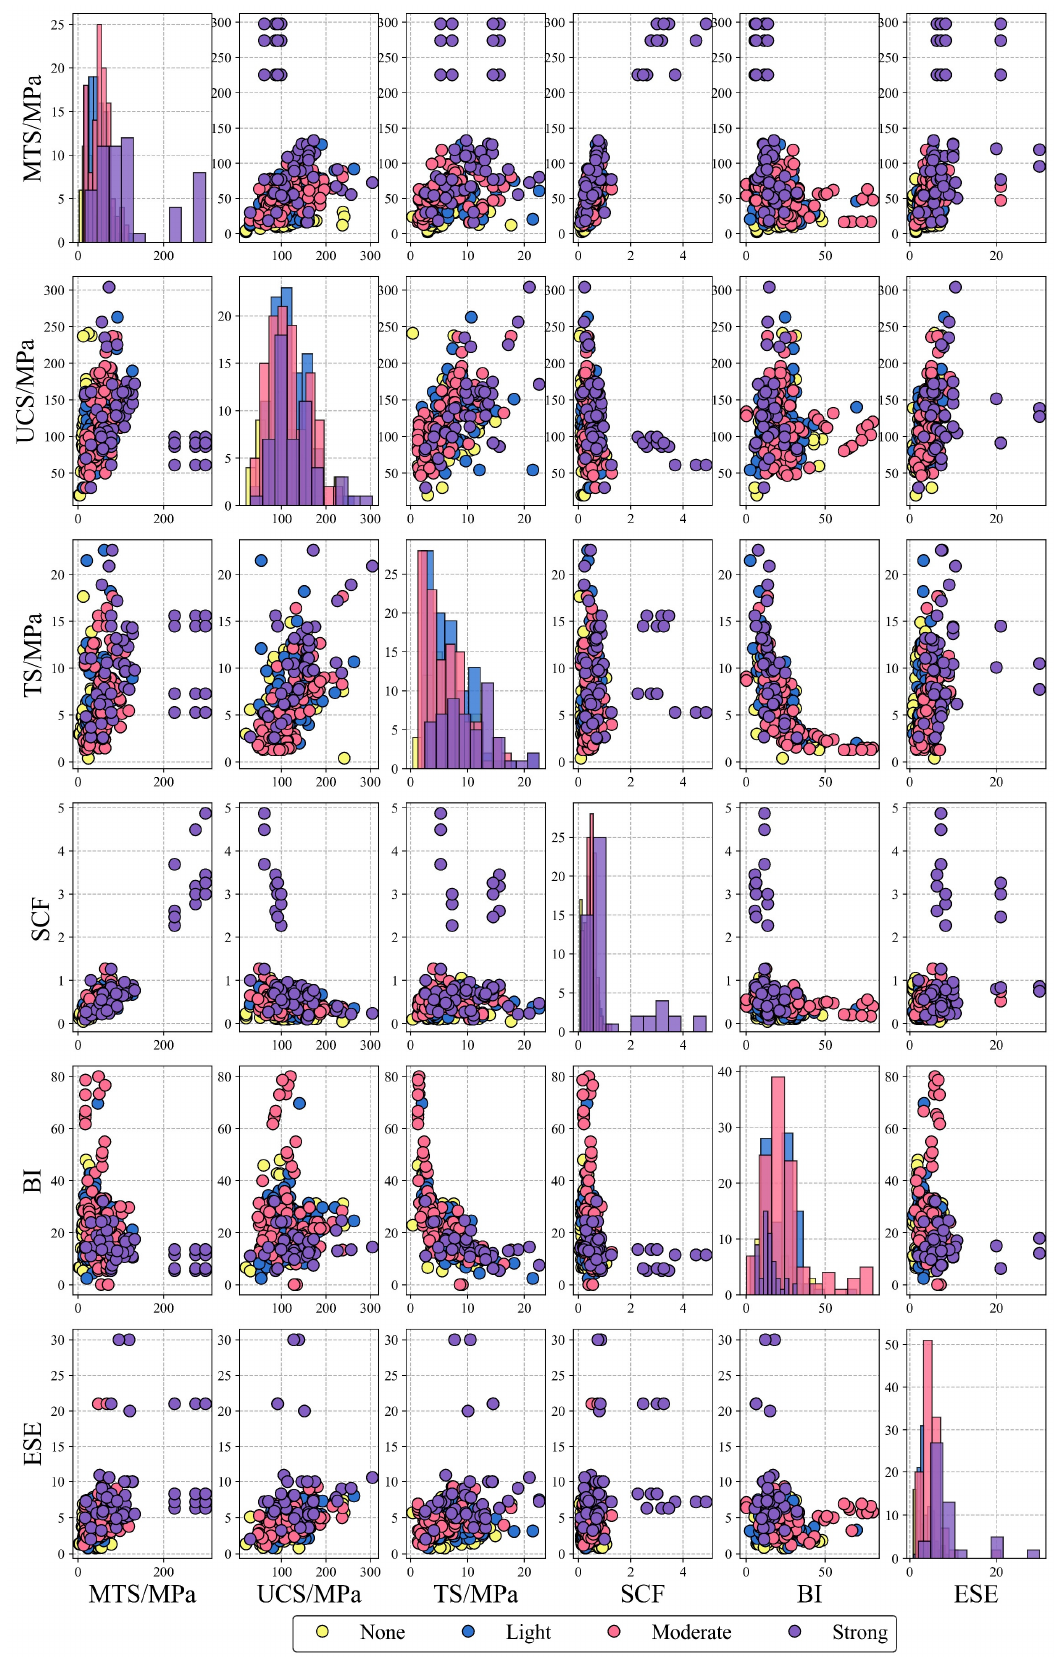
Figure 4. The scatter distribution of the database.